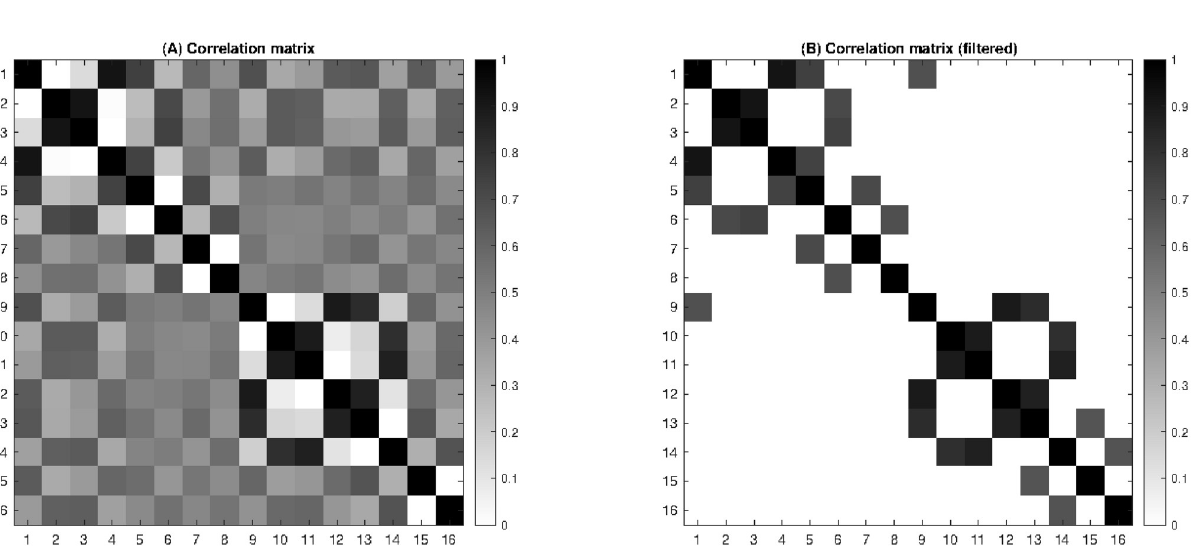
Fig 18. Correlation matrix of the motion scheme of the kinematic model. (A) Each coefficient c motion scheme of Fig 17. (B) The same matrix filtered by a threshold at 0.66 ( * 2/3) reveals non-trivial coordination patterns common to Steffen and